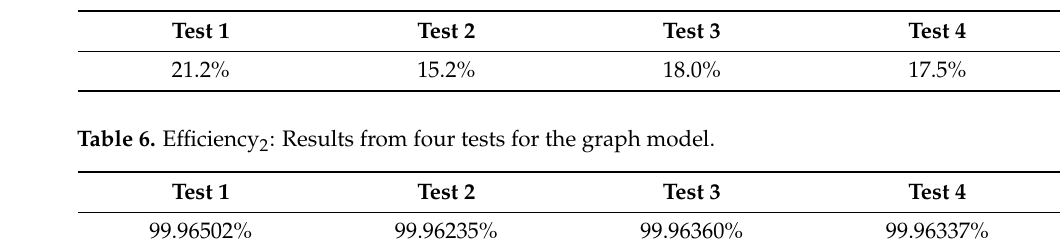
Table 5. Efficiency 1 : Results from four tests for the graph model.